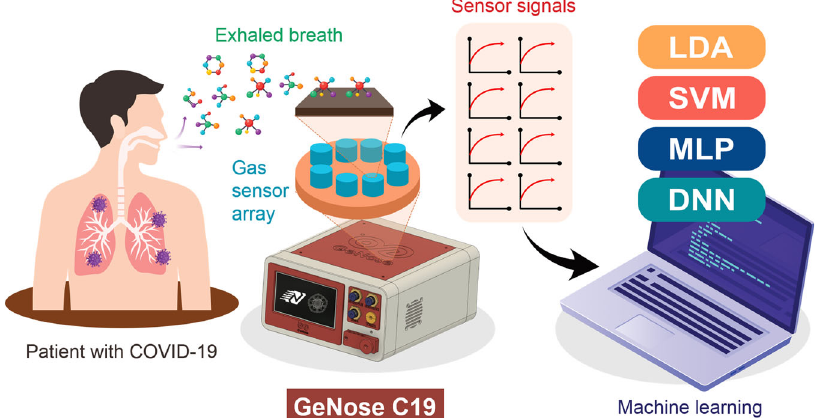
Fig. 1 Illustration of the fast and noninvasive COVID-19 detection utilizing portable electronic nose (GeNose C19) integrated with arti fi cial intelligence (AI). Four different machine learning algorithms (i.e., linear discriminant analysis (LDA), support vector machine (SVM), stacked multilayer perceptron (MLP), and deep neural network (DNN)) were employed to differentiate and classify the exhaled breath patterns of the patients, which were measured by 10 different metal oxide semiconductor gas sensors.